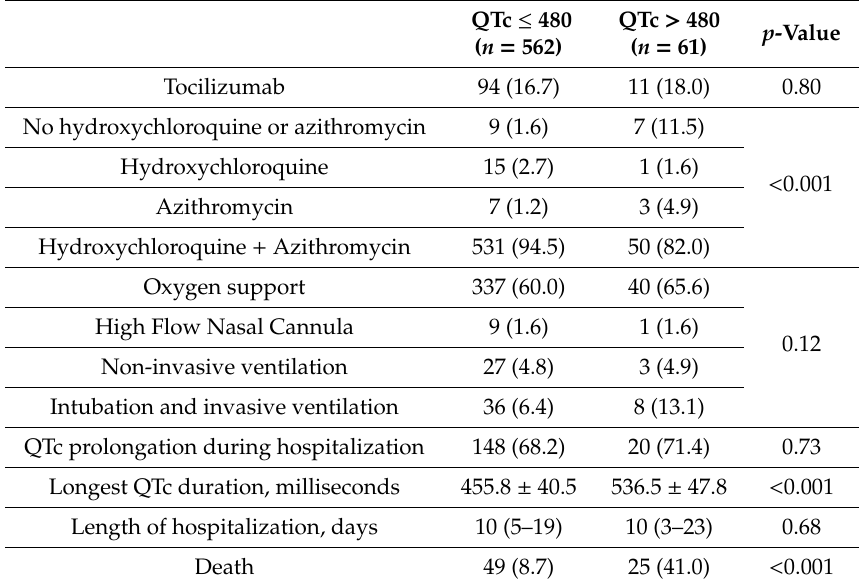
Table 4. In-hospital treatment and outcome in patients with and without prolonged QTc on admission.